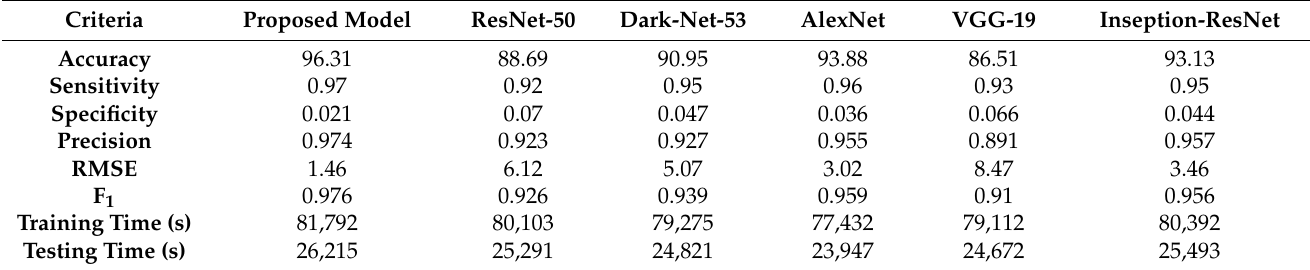
Table 2. Comparison of applied deep learning models’ performances with data augmentation.